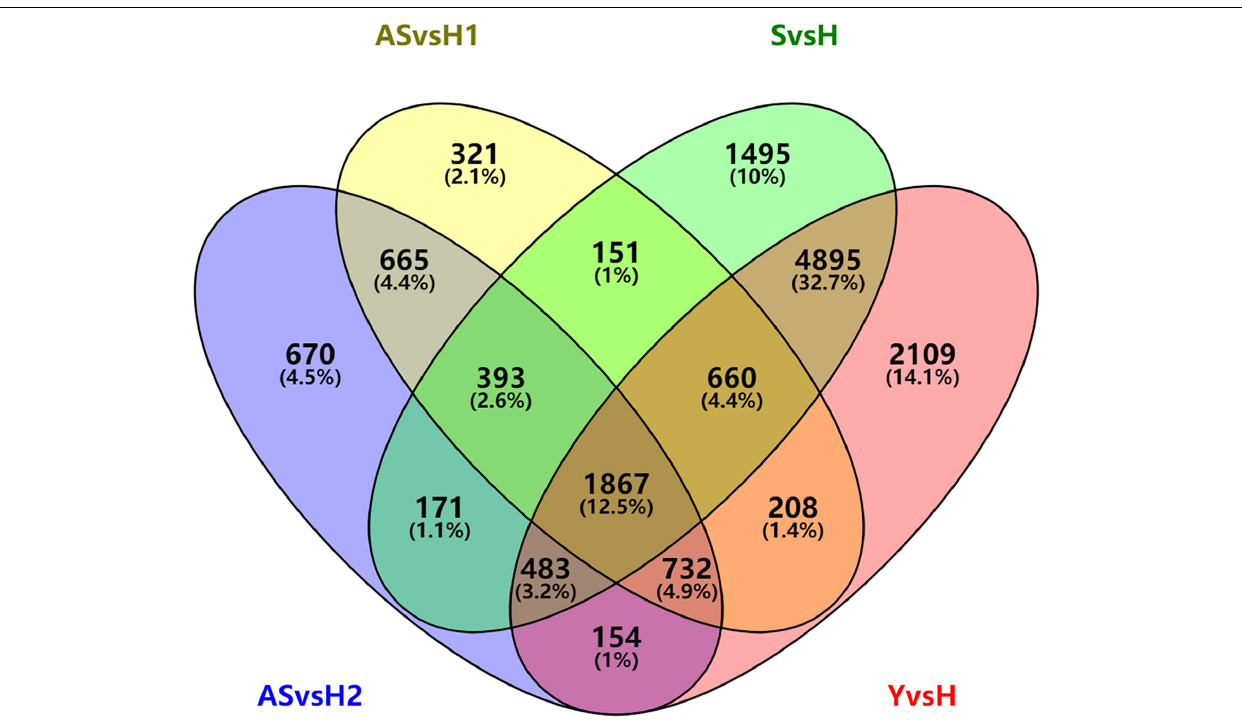
target an overexpressed ZIP5 transporter (CRO_T005117).